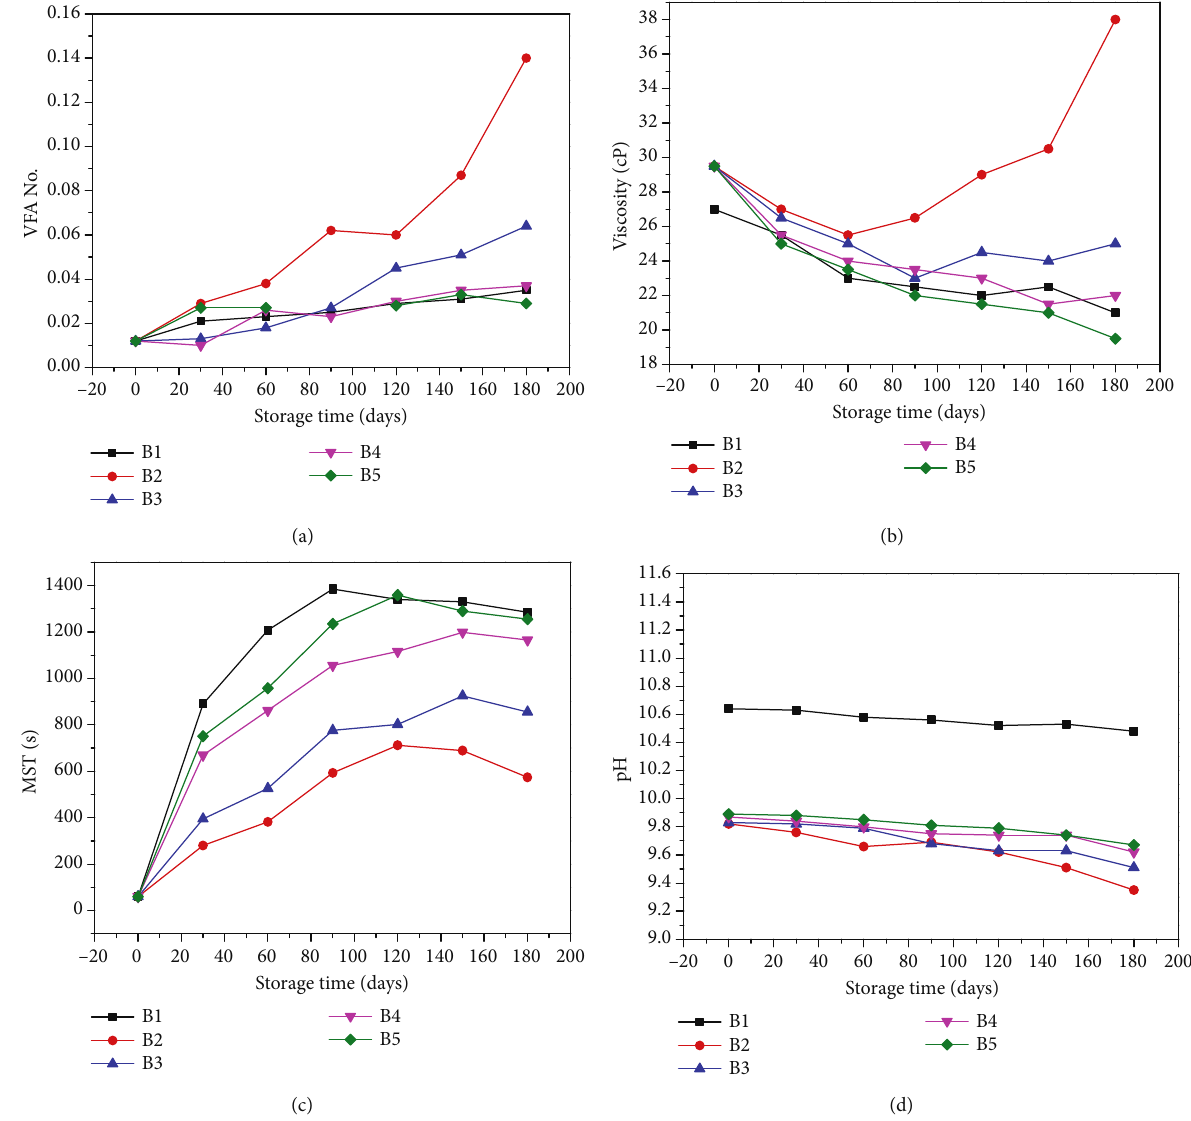
Figure 2: Properties versus the storage time of the CNRL: (a) VFA No.; (b) viscosity; (c) MST; and (d)